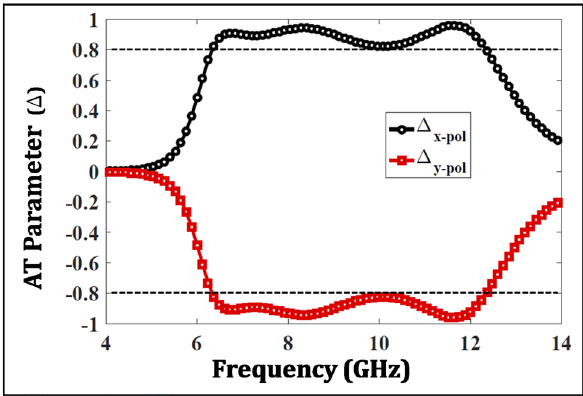
Figure 6. Asymmetric transmission parameter.